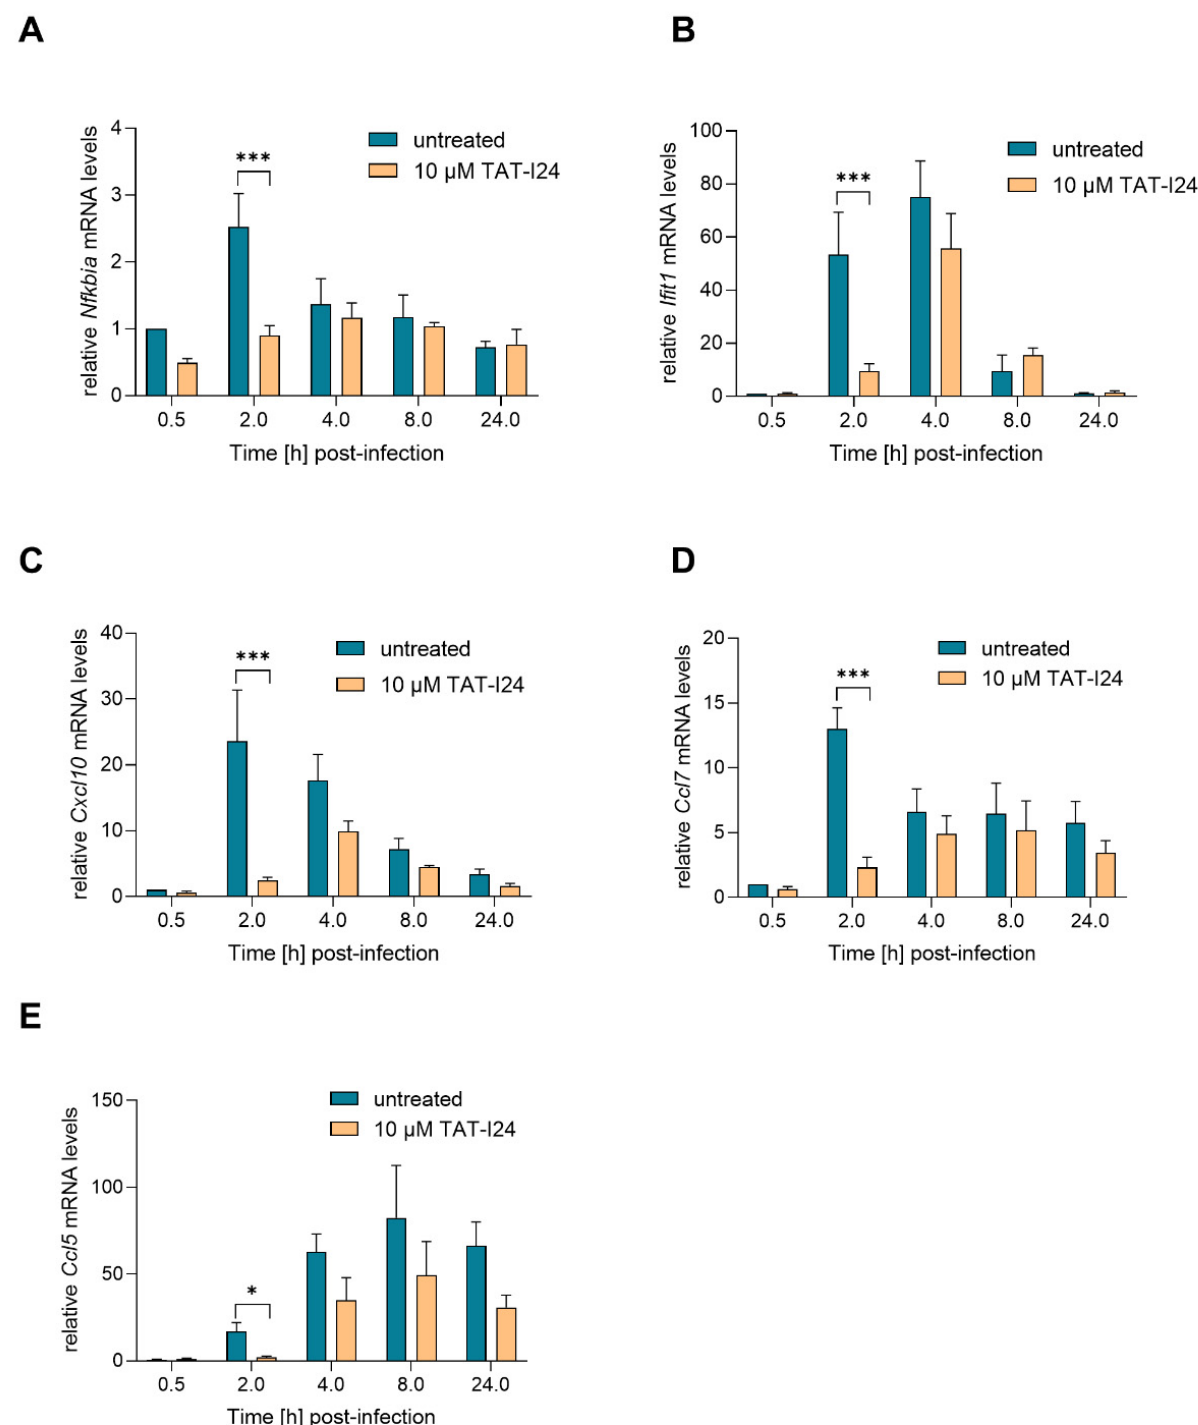
Figure 3. Levels of host-cell transcripts relative to the housekeeping gene Gapdh ( A , Nfkbia ; B , Ifit1 ; C , Cxcl10 ; D , Ccl7 ; E , Ccl5 ) in NIH/3T3 cells infected with MCMV (MOI 1) in the presence or absence of 10 µ M TAT-I24. Fold change in transcripts levels (mean ± standard error of the mean) from four independent experiments is shown. Multiple t-test was used for statistical analysis; * statistically significant at p ≤ 0.05, *** statistically significant at p ≤